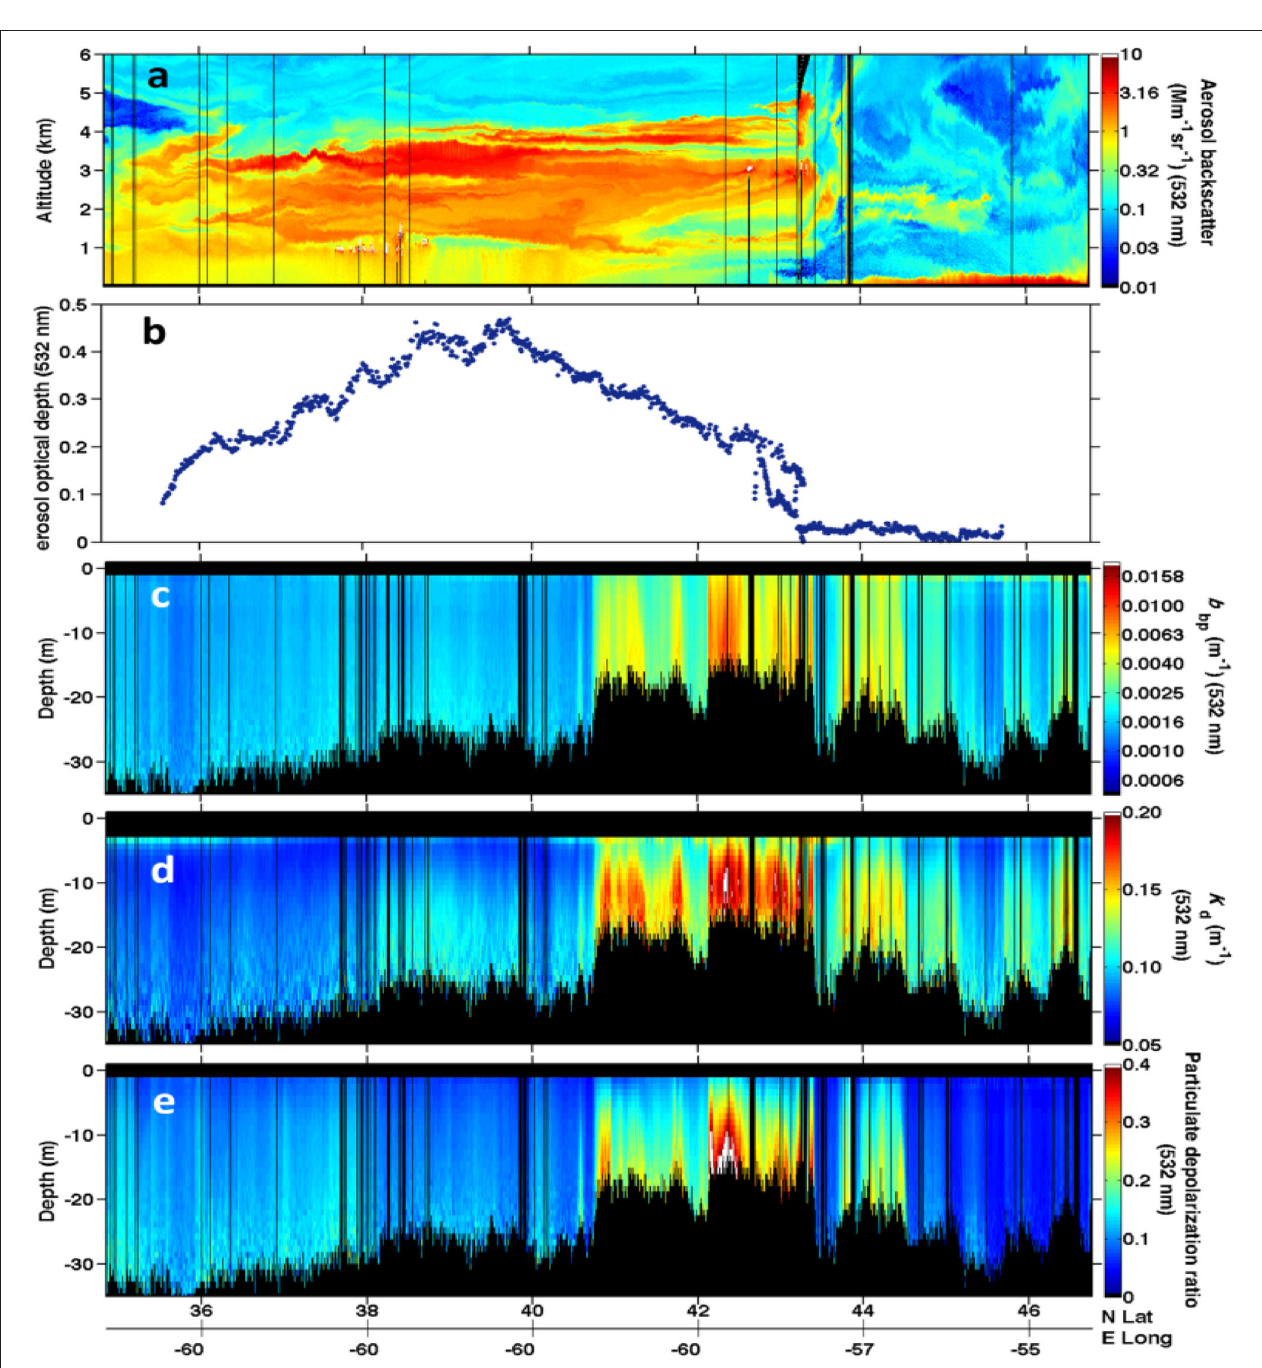
FIGURE 3 | Aerosol backscatter (a) , aerosol optical depth (b) , b bp (c) , K d (d) , and particulate depolarization (e) retrievals from HSRL-1 on 13 May 2016 NAAMES flight in the Western North Atlantic Modified from Neukermans et al.